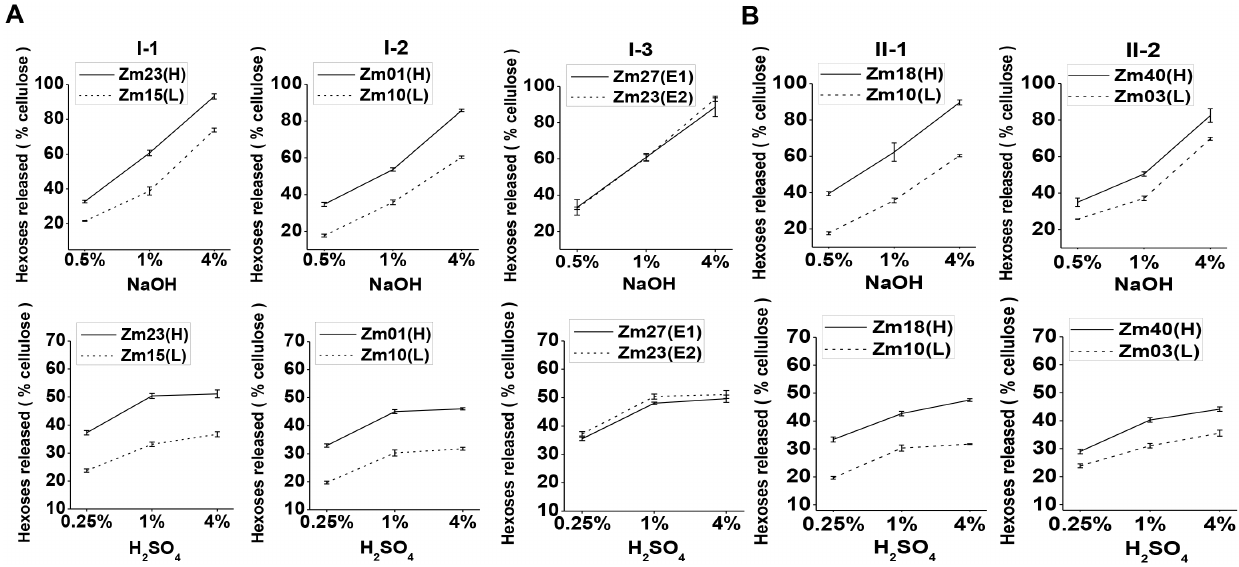
Figure 2. Hexoses yields released from enzymatic hydrolysis after NaOH and H 2 SO 4 pretreatments in corn samples. (A) Pairs I-1, I-2 and I-3 samples; (B) Pairs II-1 and II-2 samples. Bar indicated as 6 SD (n=3).